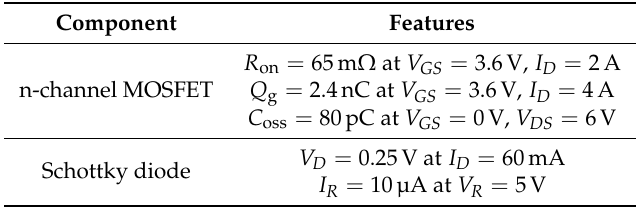
Table 3. List of the relevant features of the components selected to implement the buck-boost